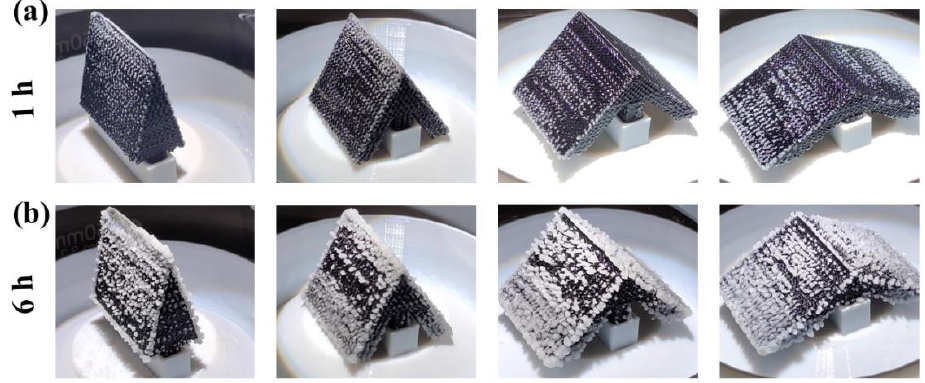
Figure 7. Digital photograph of salt crystallization: ( a ) 1 h operation of the crystallizer; ( b ) 6 h operation of the crystallizer.